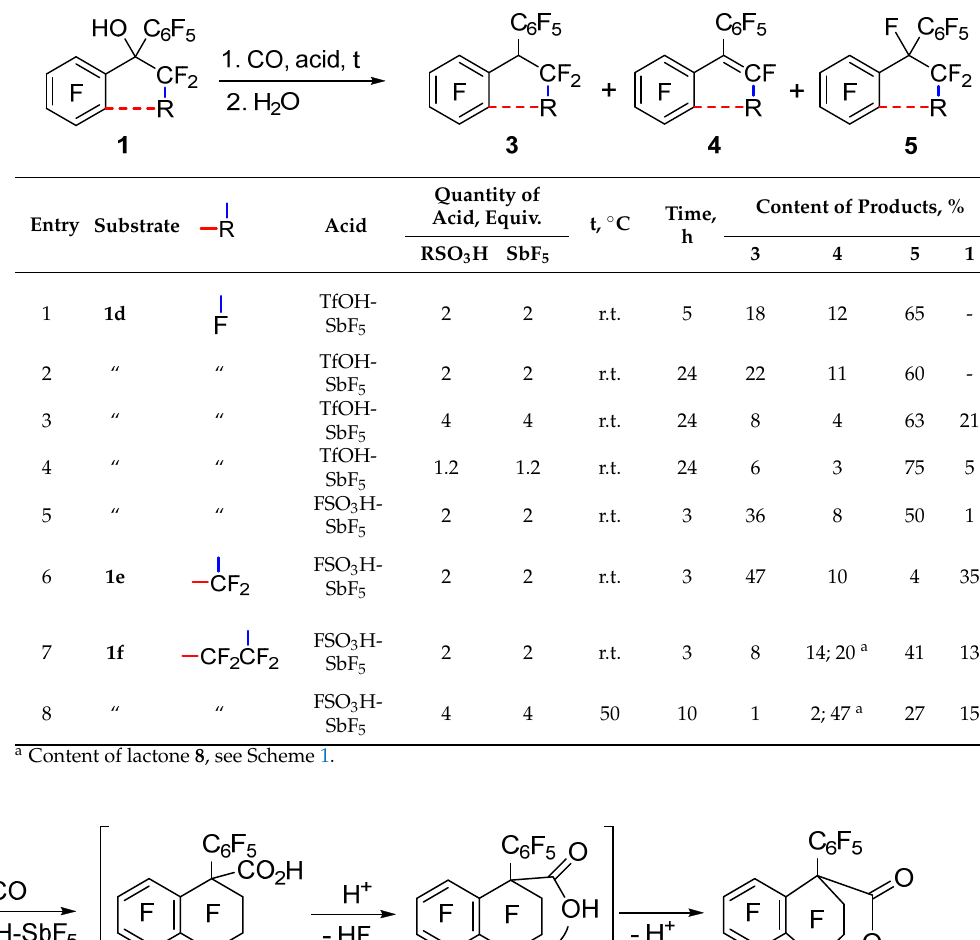
Table 2. Carbonylation of tertiary perfluorinated 1,1-diarylalkan-1-ols 1d – f in superacids.